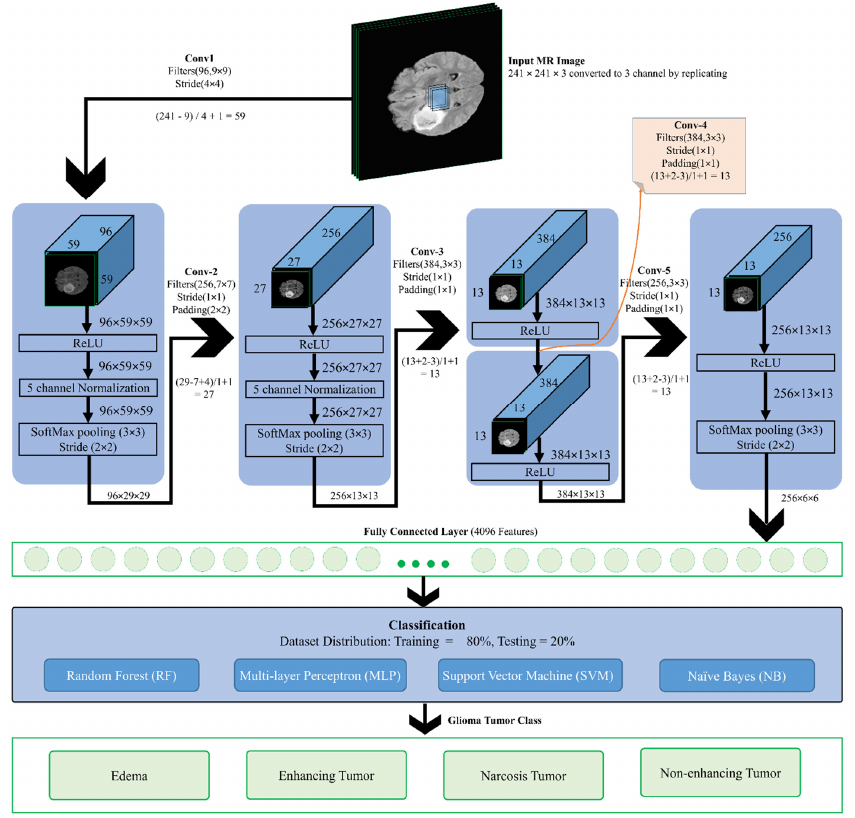
Figure 1. The architecture of the proposed CNN Features based Multiclass Tumor